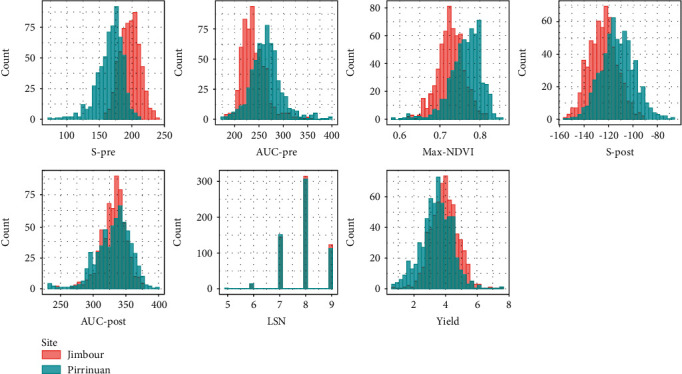
Histograms of canopy traits using raw data of Jimbour and Pirrinuan.